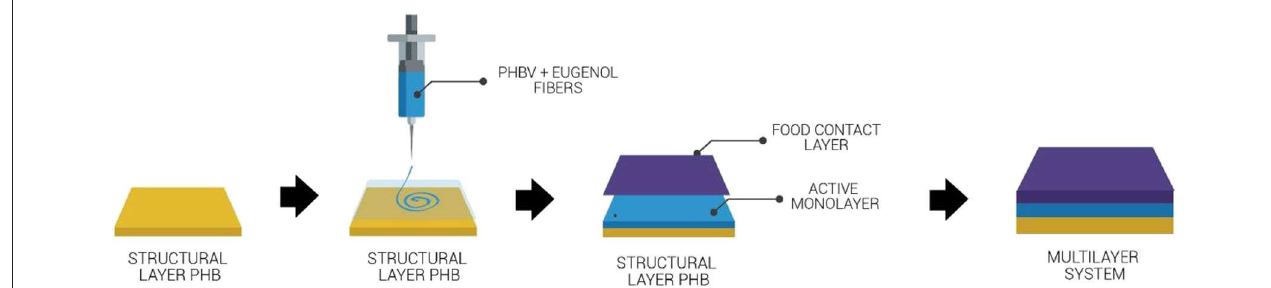
FIGURE 1 | Process to obtain the multilayer system of poly(3-hydroxybutyrate) (PHB) sheet/electrospun poly(3-hydroxybutyrate- co -3-hydroxyvalerate) (PHBV) interlayer containing eugenol/PHBV film.